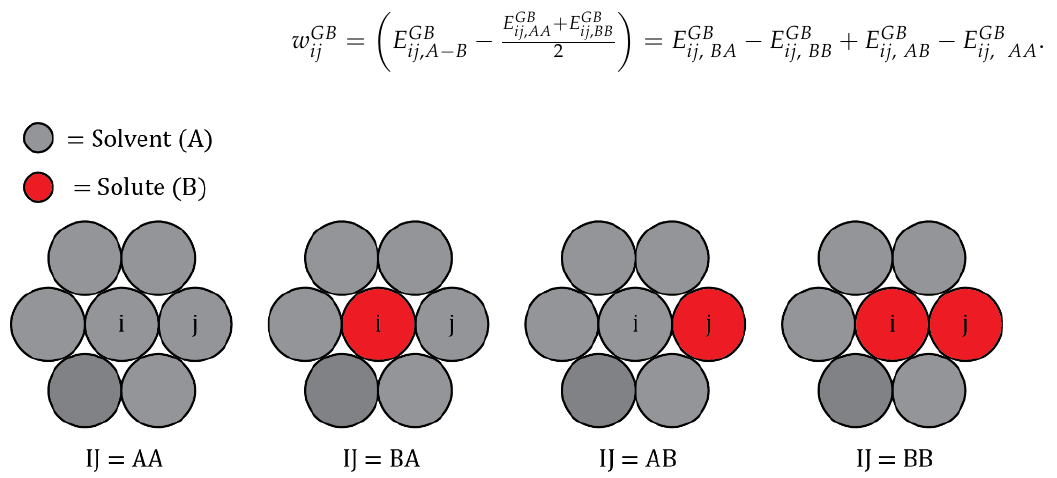
Figure 5. Example 2d atomic configurations used to calculate the per-bond parameter ѡ 𝑖𝑗𝐺𝐵 for bond i-j , by measuring the per-atom energy of atom I in the fully relaxed polycrystal, 𝐸 𝑖𝑗,𝐼𝐽𝐺𝐵 , where atoms I and J can be either solvent A or solute B.